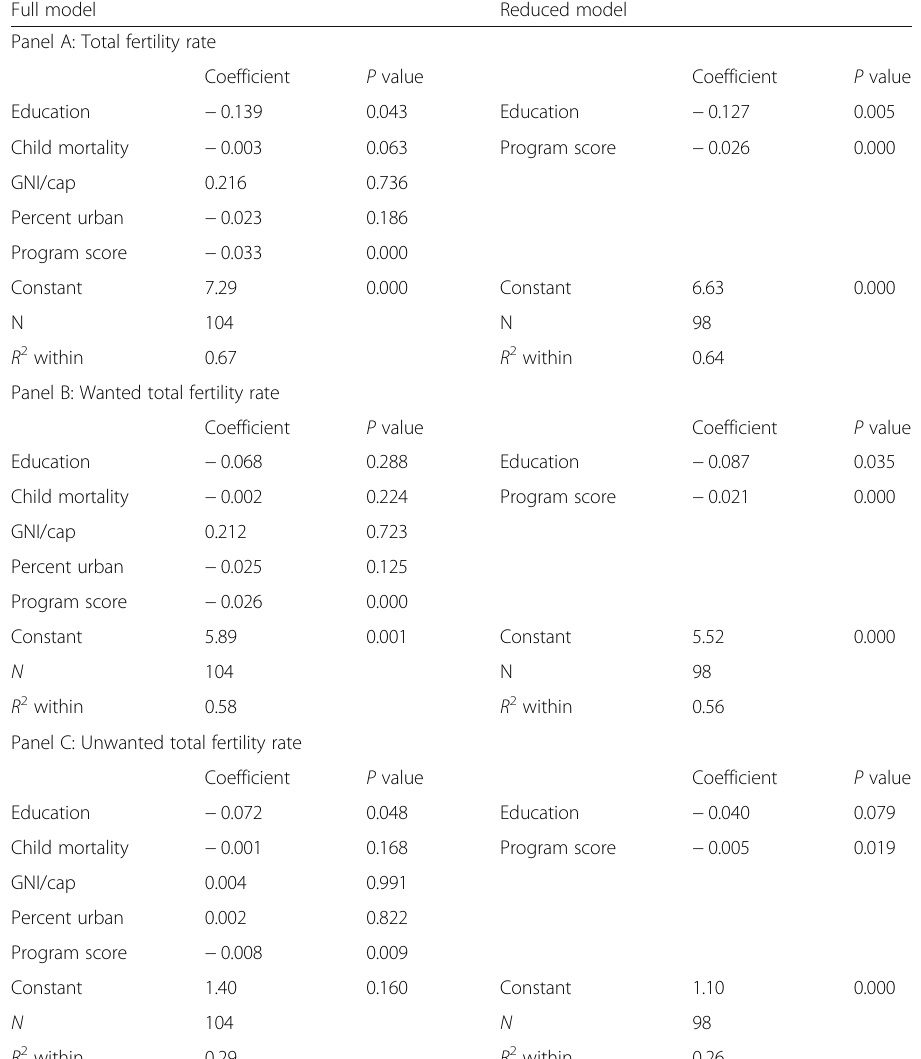
Table 2 Results of fixed effects regression models of fertility, wanted fertility and unwanted fertility on socioeconomic variables and program score in 25 Sub-Saharan Africa countries with 104 DHS